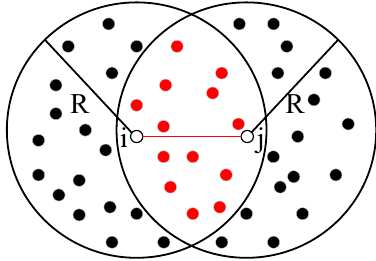
Figure 1. Hop count between the nodes connected by the three red lines is one hop, but the actual distance between them is quite different.